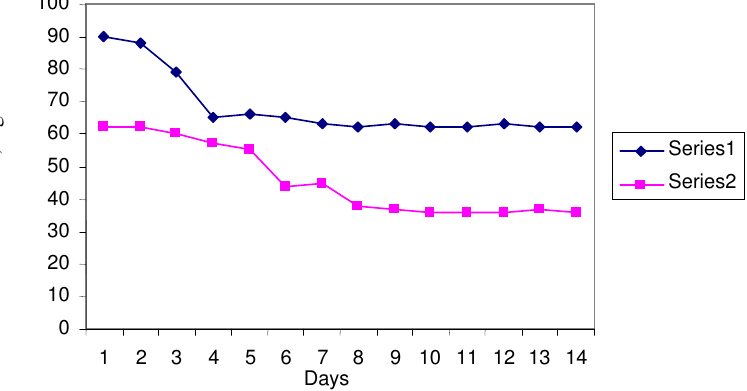
Figure 2. DOC elimination – anaerobic conditions.